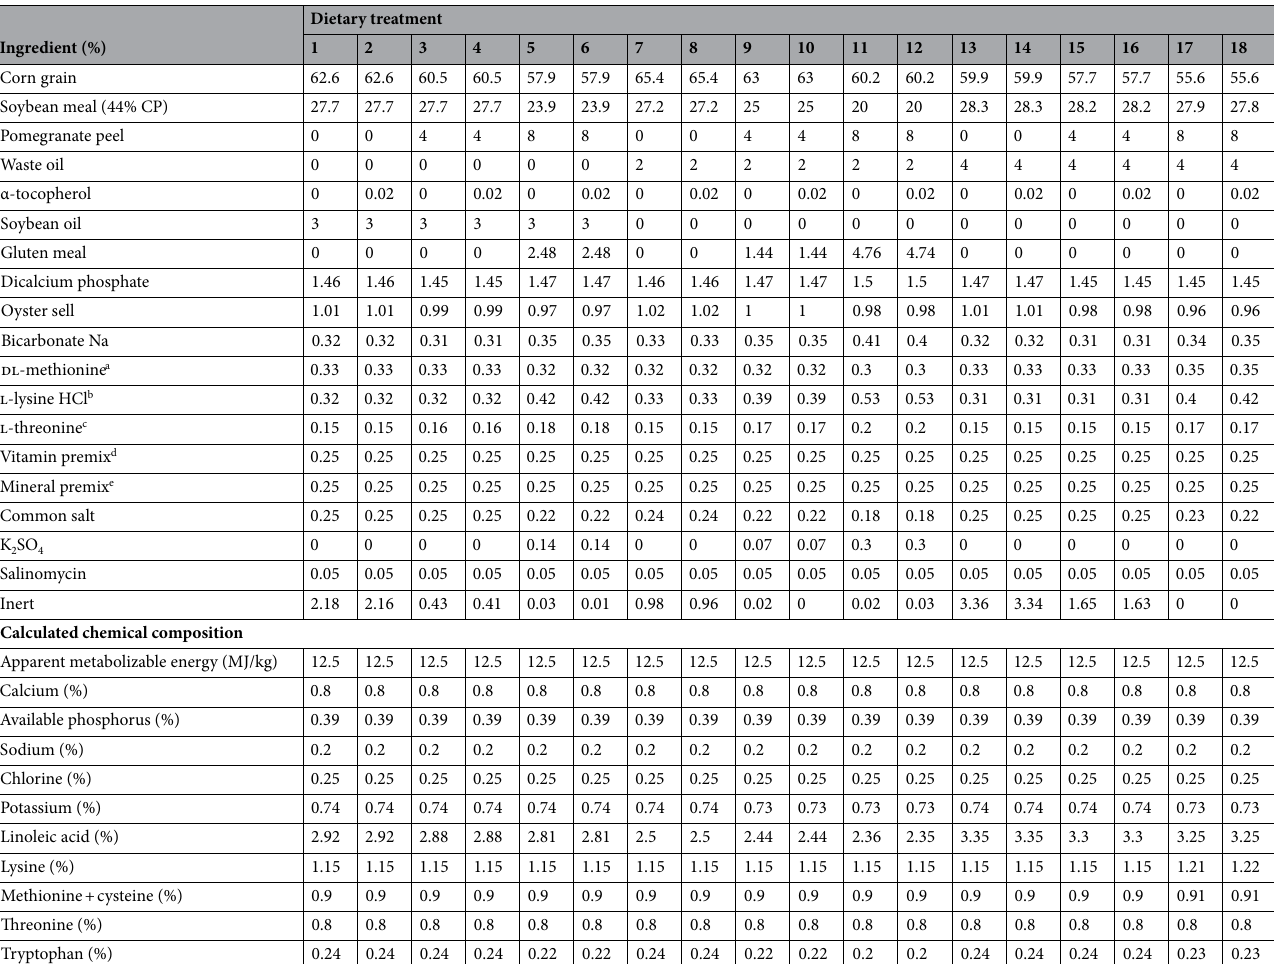
Table 2. Ingredient composition and calculated chemical composition of the diets (25–49 days). a dl-